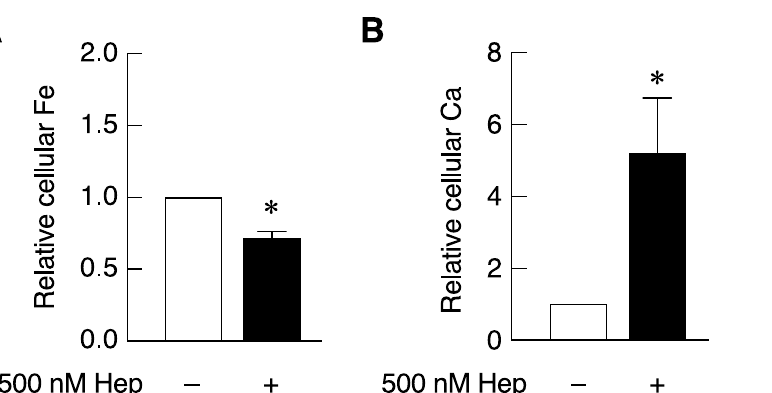
Fig 2. Hepcidin suppressed cellular iron uptake but activated cellular calcium uptake in Caco-2 cells under physiological condition. ( A ) The basal level of cellular iron and ( B ) cellular calcium in Caco-2 cells upon hepcidin treatment. The same sample groups were measured by FAAS after exposed to 500 nM hepcidin for 30 hours; data was analyzed from three independent biological experiments (n = 3). P -value was calculated using one tailed Mann- Whitney U Test. � P < 0.05 as compared to control